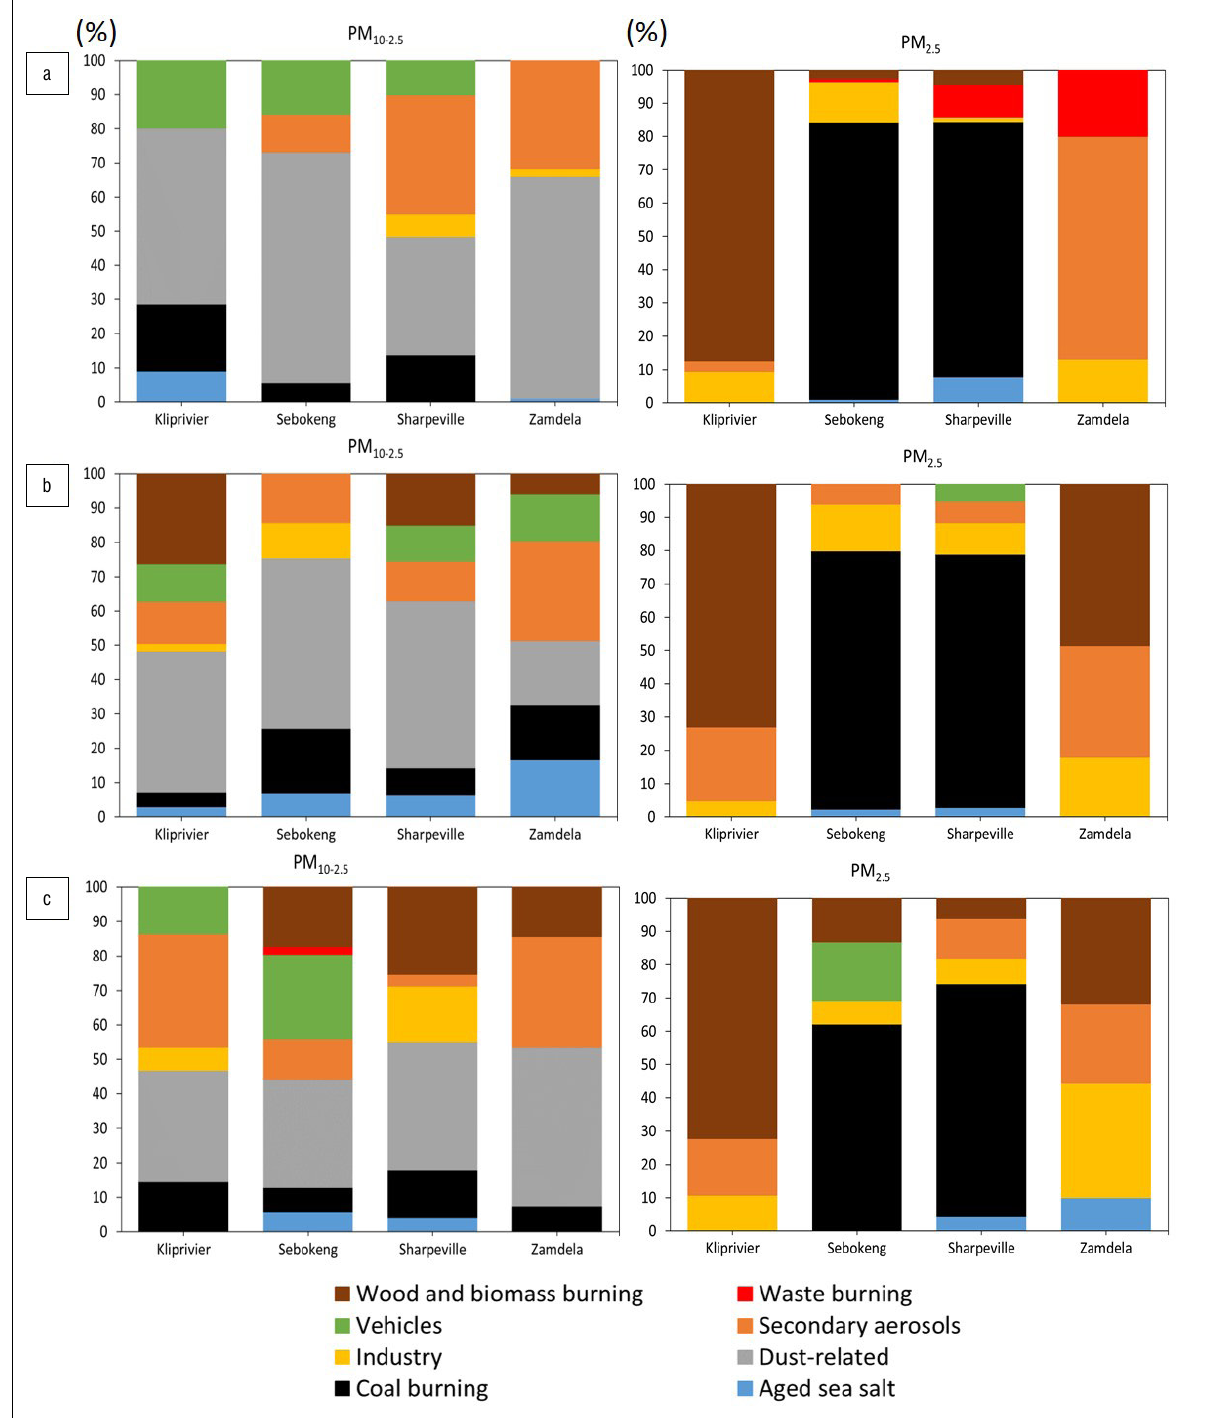
and PM at all sites for (a) summer/autumn (b) winter and (c) 10-2.5 2.5